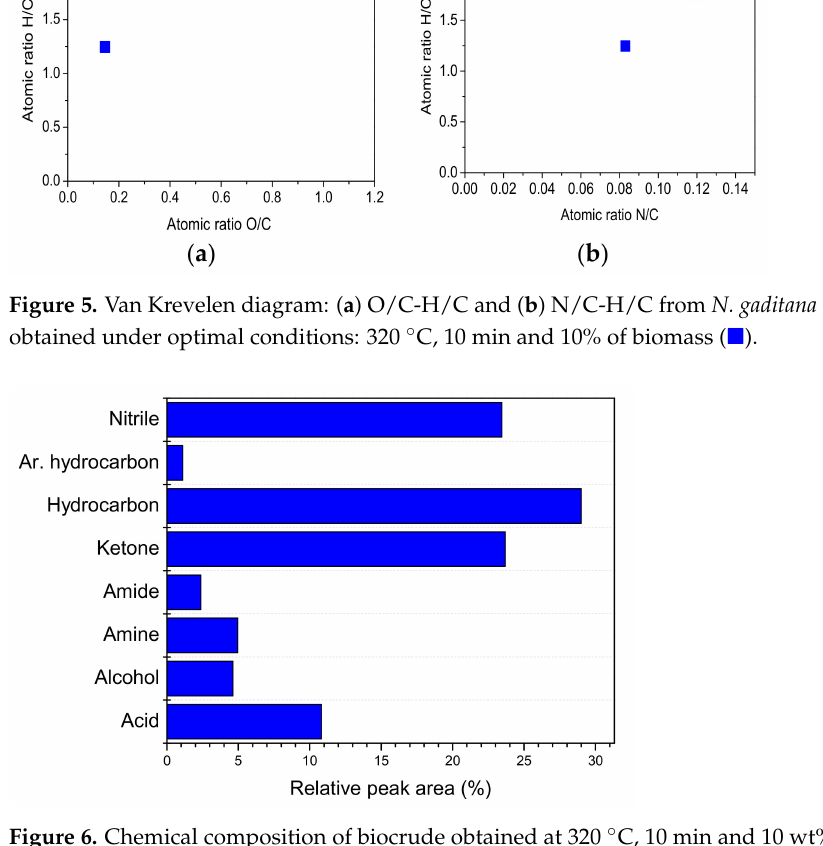
Figure 6. Chemical composition of biocrude obtained at 320 ◦ C, 10 min and 10 wt% of microalgae.